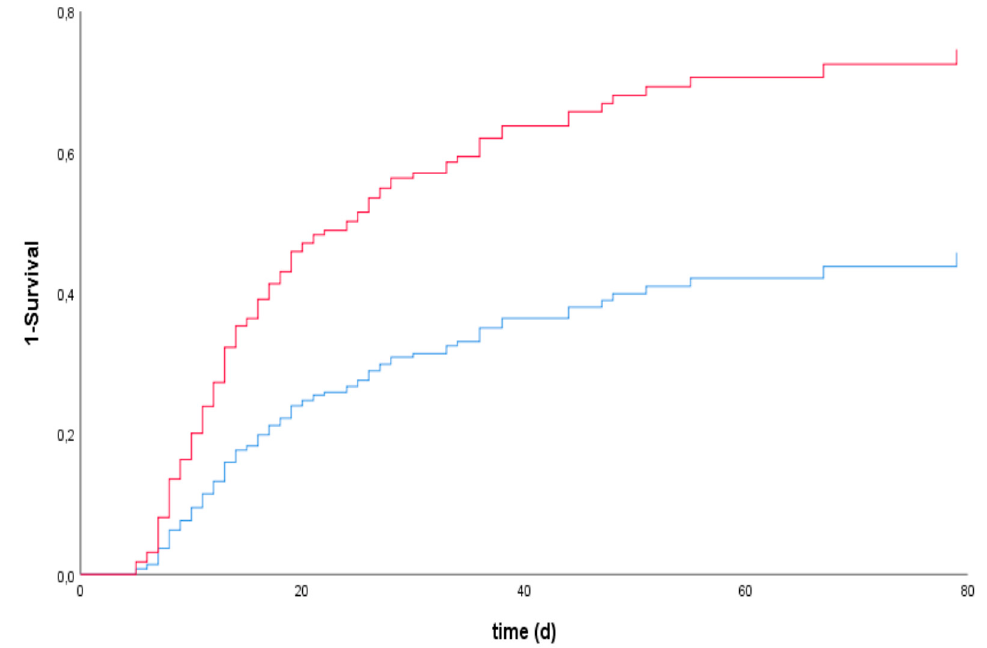
Figure 3. Cox proportional hazards model for investigating the association between the survival time of patients undergoing ECLS therapy and bilirubin levels on day 5 if bilirubin was > 2.23 mg / dL (red line) or < 2.23 mg / dL (blue line) (cutoff value as determined by the Youden index), including a predefined multivariable adjustment.